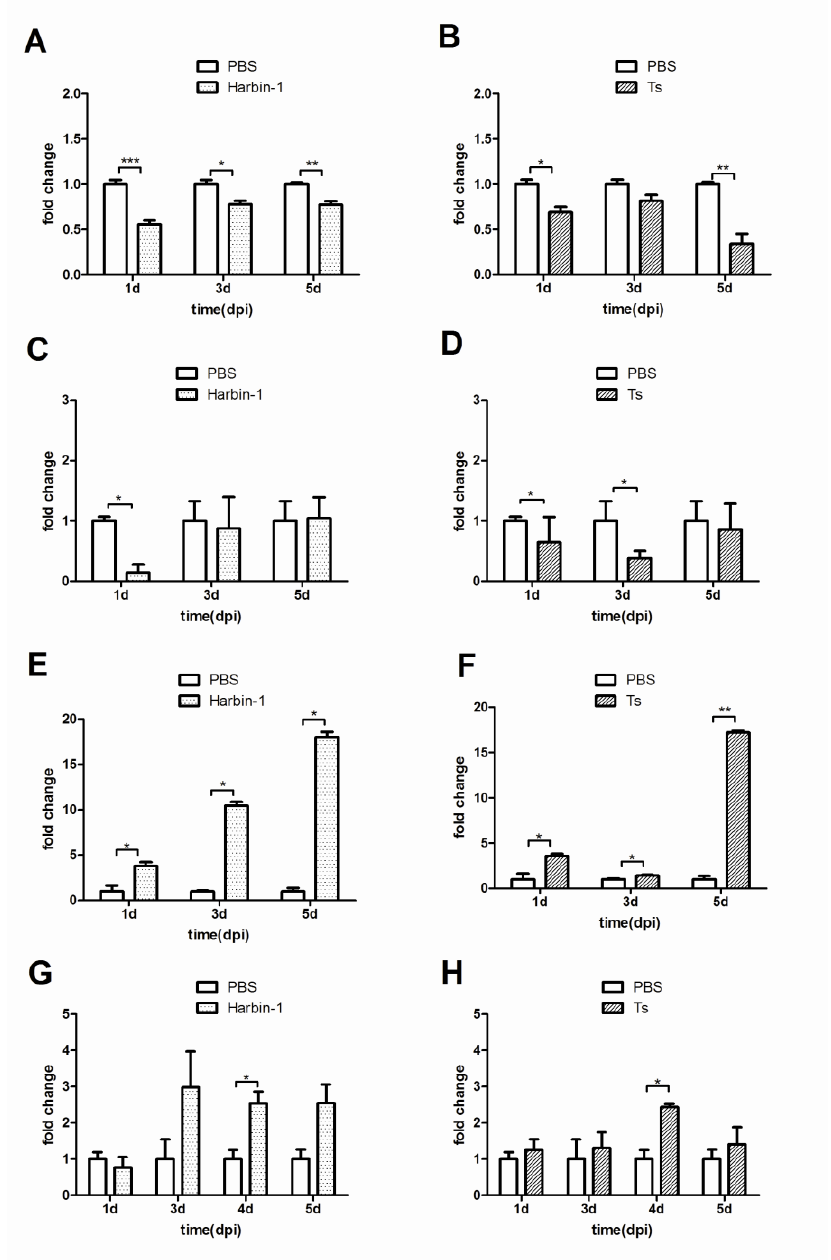
Figure 3. Changes in the CD4+CD25+ cell levels in the thymus and spleen and cytokine expression levels in the thymus of IBDV-infected SPF chickens. ( A , B ) Changes in the CD4+CD25+ cell level in the thymus of SPF chickens infected with the Harbin-1 or Ts strain; ( C , D ) Changes in CD4+CD25+ cell level in the spleen of SPF chickens infected with the Harbin-1 or Ts strain; ( E , F ) Changes in the IL-10 expression level in the thymus of SPF chickens infected with the Harbin-1 or Ts strain; ( G , H ) Changes in the TGF-β expression level in the thymus of SPF chickens infected with the Harbin-1 or Ts strain. Note: the y-axis indicates the fold change of the IBDV group/PBS group, and the x-axis shows the time after SPF chickens were infected with the Harbin-1 or Ts strain. Data represent mean ± SEM from 3–5 individuals. * P ≤ 0.05; ** P ≤ 0.01; *** P =